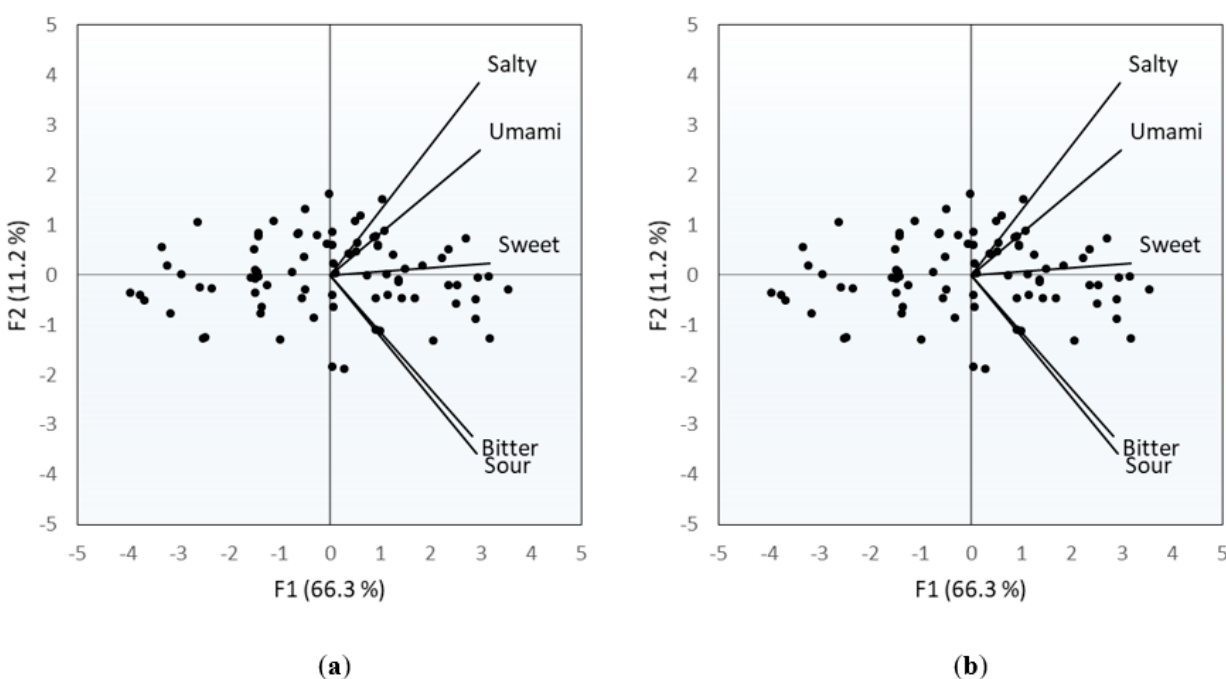
Figure 5. Links between sensitivity for the five tastes (82 subjects). PCA (correlation): axes 1–2 ( a ) and 1–3 ( b ).